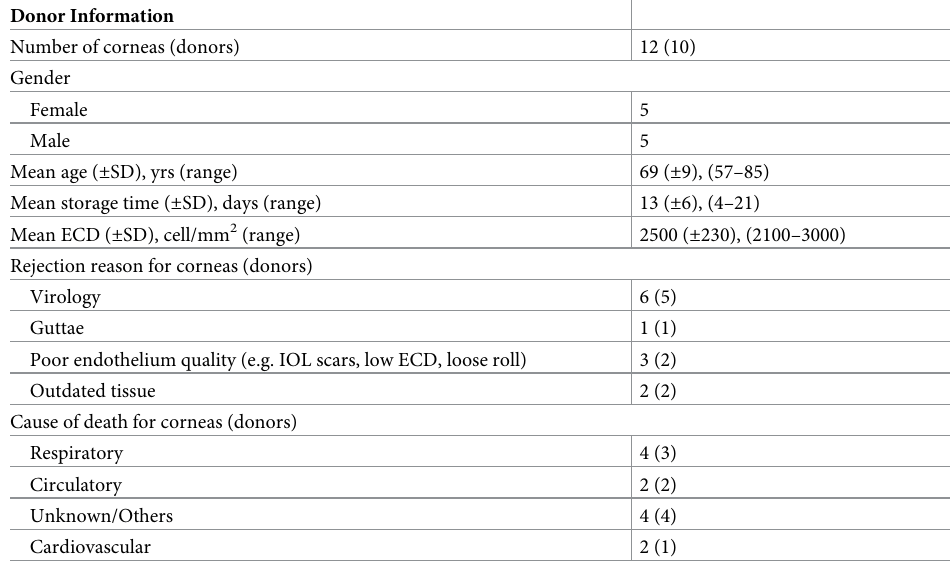
Table 1. Basic donor demographics of corneas used for small diameter DMEK graft preparation.